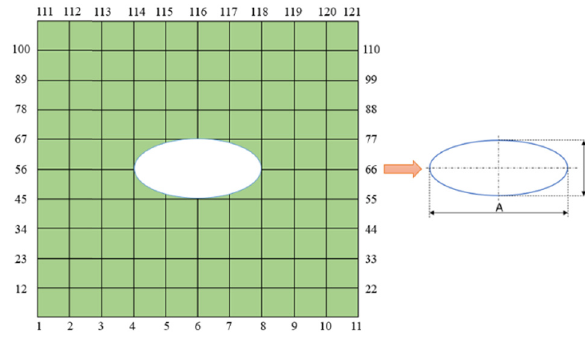
Figure 10: Schematic representation from the top of the SFGM square plate with elliptical cutout.